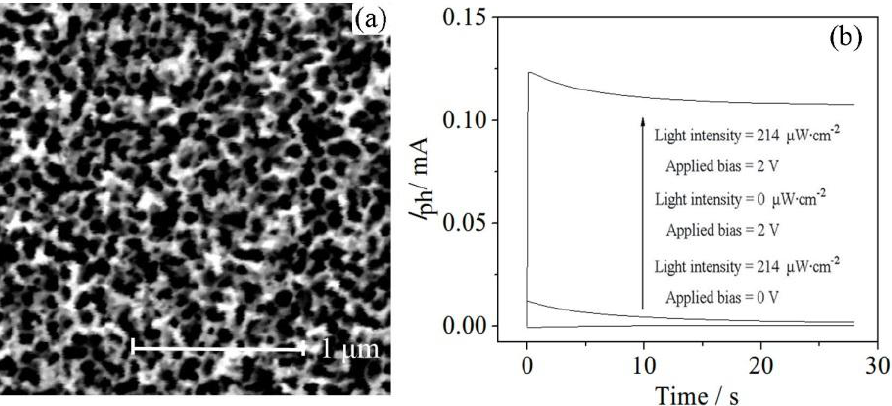
Figure 3. ( a ) SEM image of WO different